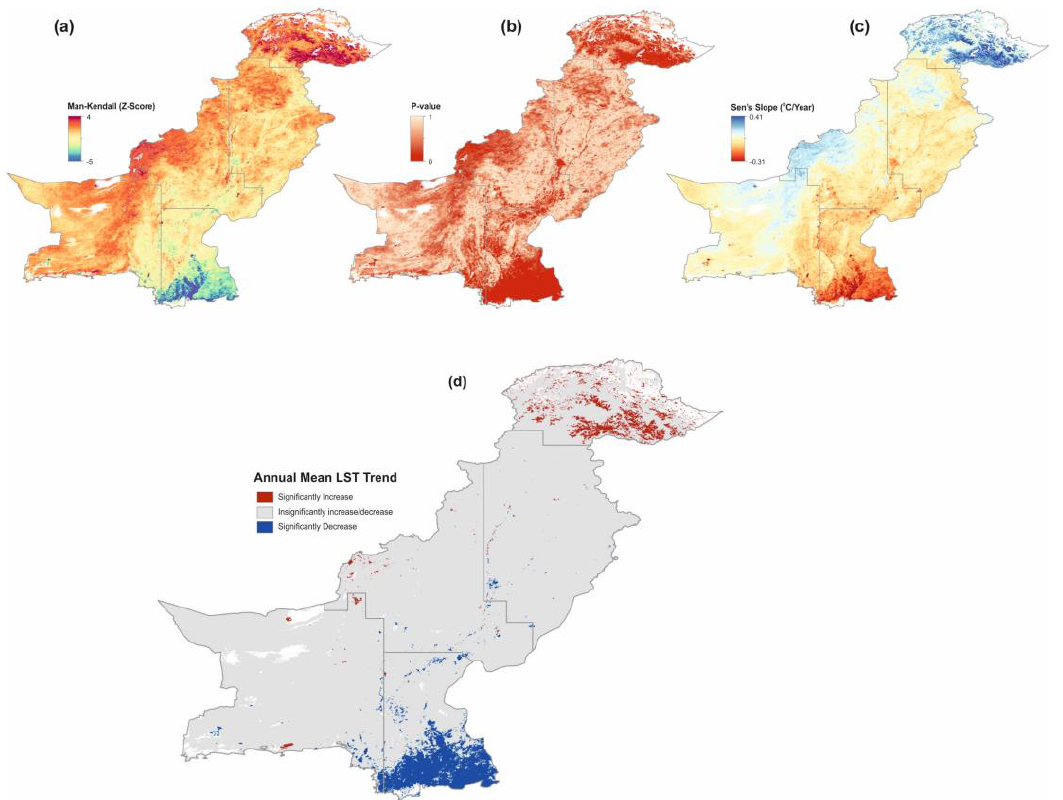
Figure 7. Spatial distribution of ( a ) Mann – Kendall, ( b ) Sen’s Slope , ( c ) Level of Significance ( p -value), ( d ) Statistically significant data at 99% level of confidence. ( d ) Statistically significant data at 99% level of Table 2. MK trend test ( Z ) statistics, Sen’s slope , and p value for the LST trends analysis. Region